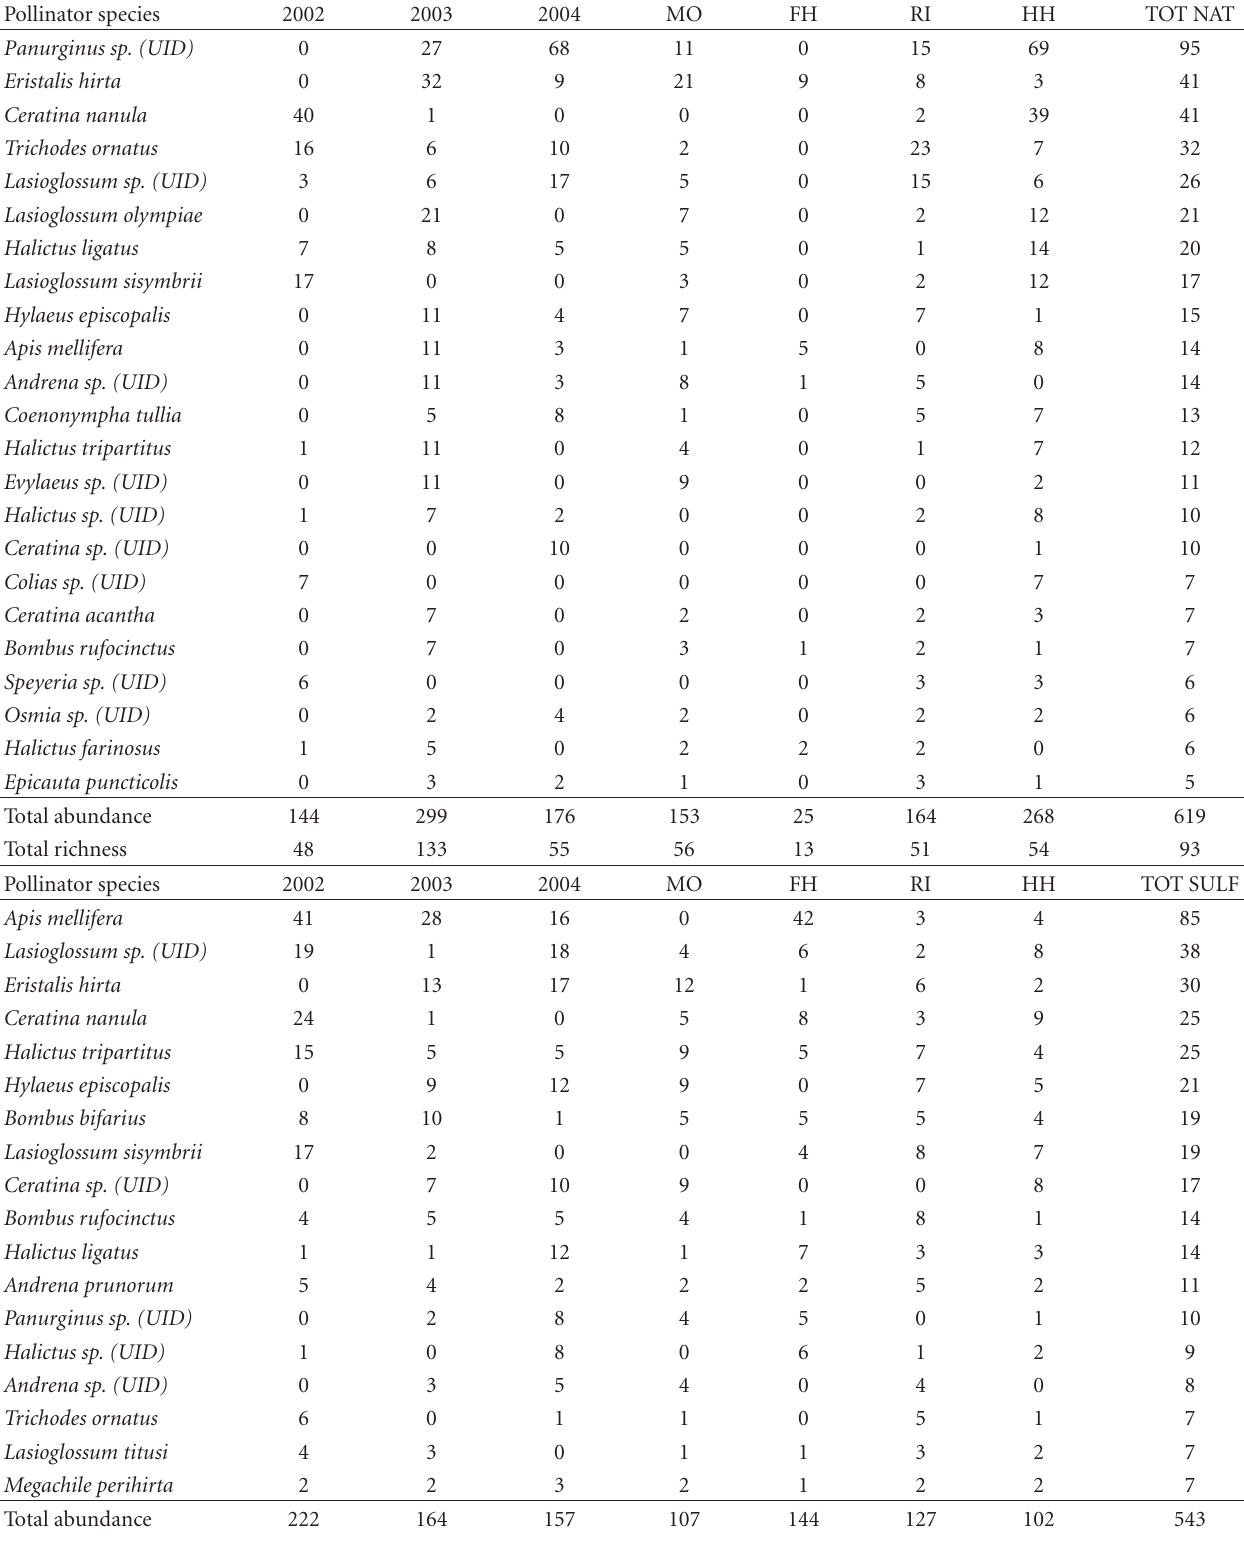
Table 1: List of most commonly observed pollinator species (total abundance ≥ 5) for sulfur and native cinquefoils, ordered by abundance for each species, at four study sites in northeastern Oregon, 2002, 2003, and 2004. KEY to abbreviations: MO: Morgan Lake; FH: Foothill; RI: Rice; HH: Ham; NAT: Native Cinquefoil; SULF: Sulfur